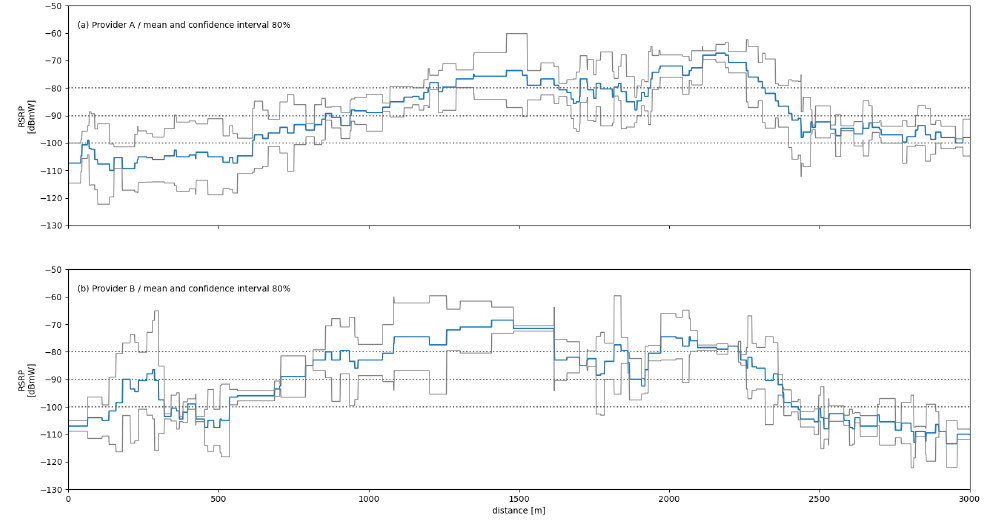
Figure 7. Mean values of RSRP as a function of distance including the limits of the confidence interval for a confidence of